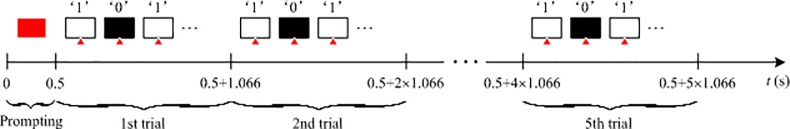
The time structure of testing trials for a target.The first 0.5 s was used for visual cue, during which the target to be tested turned red and the subject should shift his/her gaze to the target as soon as possible. Then the target was continuously tested/attended five trials, during which the red target cue was switched to the red small triangle cue below the target. The time for a trial was equal to one stimulus cycle of the 64-bit modulation codes, i.e. 1.066 seconds for the screen refresh rate of 60 Hz. The data length of a single trial was used for target recognition, i.e. 1066 sampling points for the sampling rate of 1000 Hz. Assume that the first three bits of the modulation code for the tested target is ‘101’. ‘1’ and ‘0’ denote that the target was displayed as ‘bright’ and ‘black’ respectively.